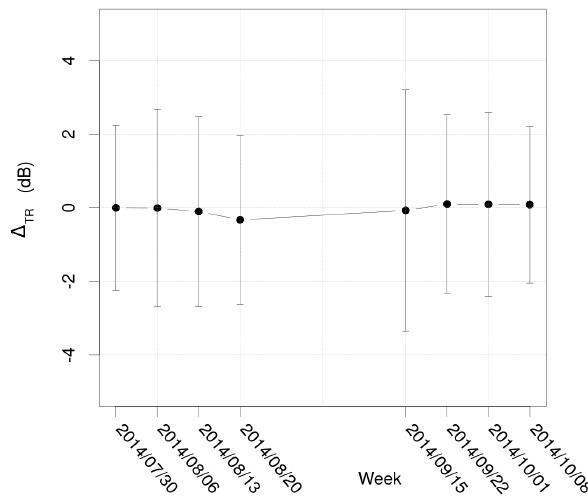
Figure 20. As in Fig. 19 but for the Monte Settepani